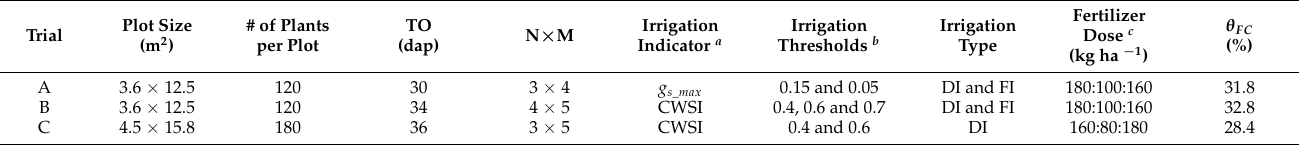
a Variable evaluated to determine the irrigation timing. b Irrigation thresholds from which the irrigation pulses were applied. c Fertilization dose based on N:P 2 O 5 :K 2